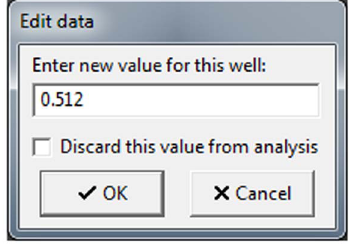
Figure 6. Marking of the discarded and changed values. Changed values appear in red, and discarded values are crossed out after data modification.